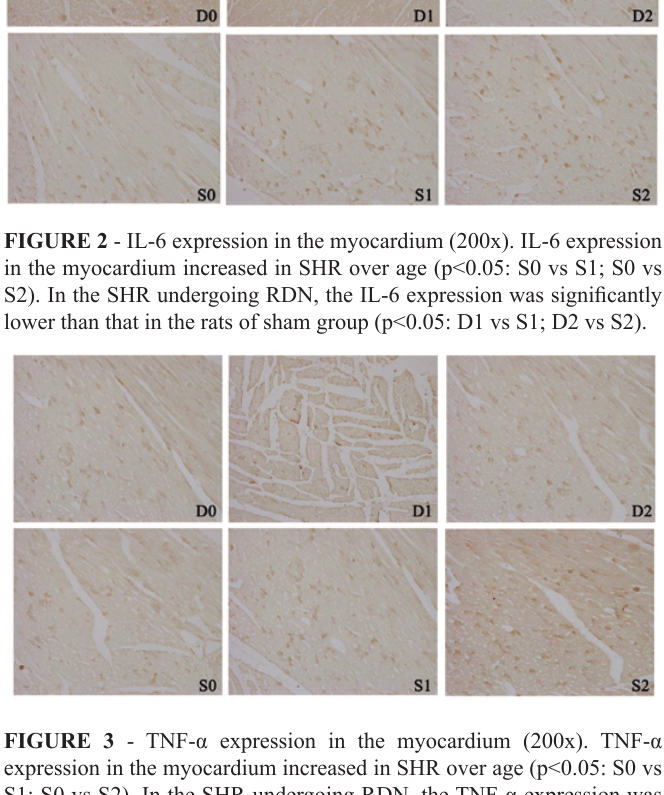
FIGURE 3 - TNF-α expression in the myocardium (200x). TNF-α expression in the myocardium increased in SHR over age (p<0.05: S0 vs S1; S0 vs S2). In the SHR undergoing RDN, the TNF-α expression was dramatically lower than that in the rats of sham group (p<0.05: D1 vs S1; D2 vs S2).